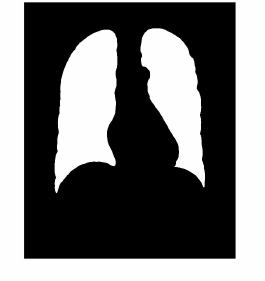
Figure 13. Ground truth